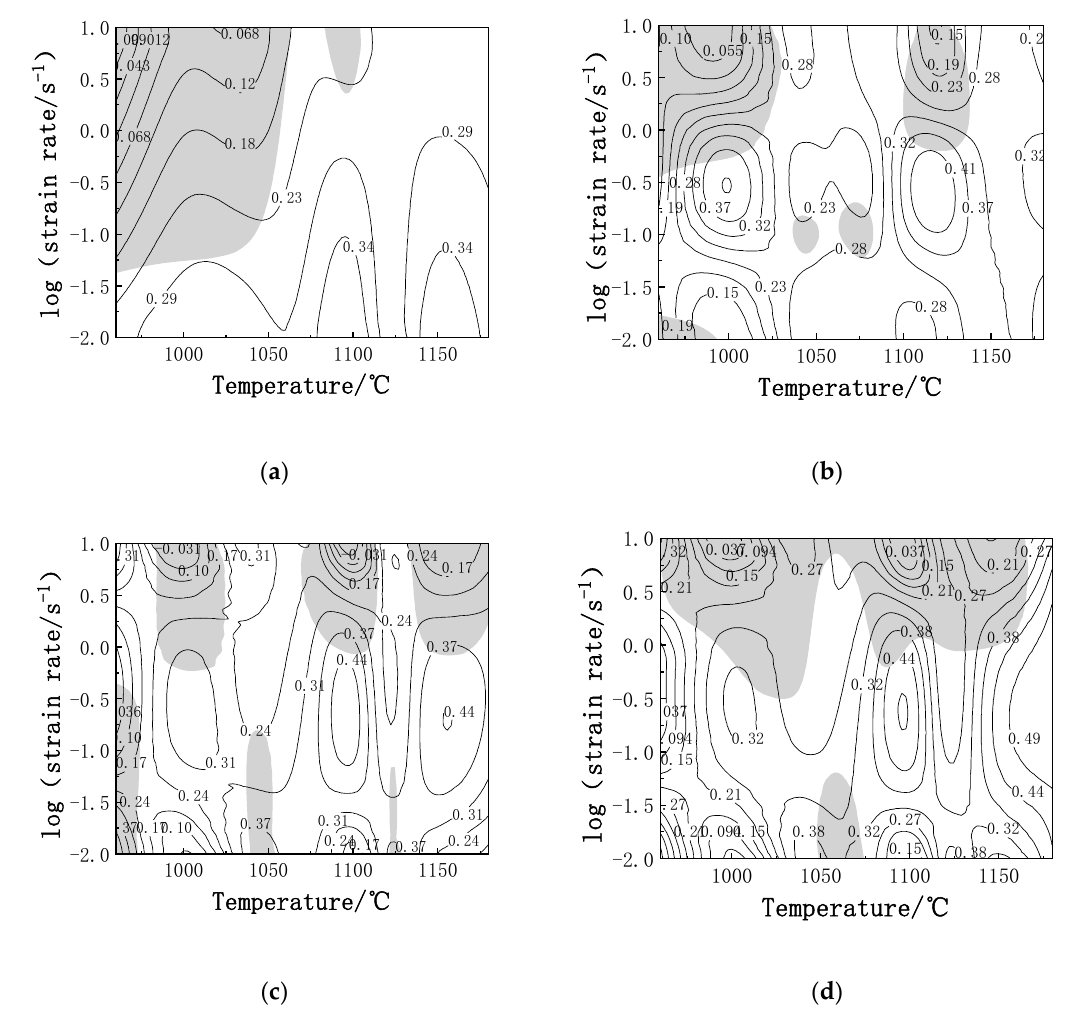
Figure 6. Processing map of HY282 alloy at different true strain: ( a ) ε = 0.2, ( b ) ε = 0.4, ( c ) ε = 0.6, ( d ) ε = 0.7.